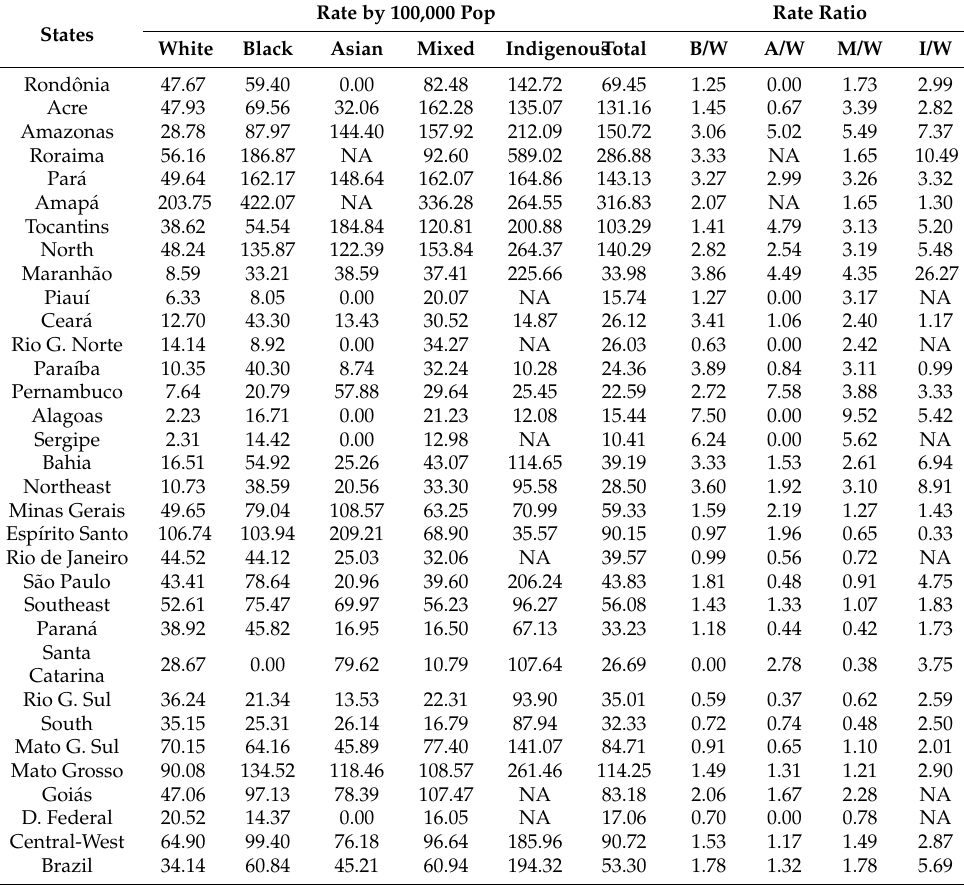
tions (5.22%) and Crotalus smaller (5.42%), compared with the total population (2.16% and 7.8%, respectively), and with the white populations (0.46% and 9.59%, respectively). Table 1. Snakebite rate per 100,000 population; rate ratio of more exposed race group by less exposed race group per state and per region, Brazil,